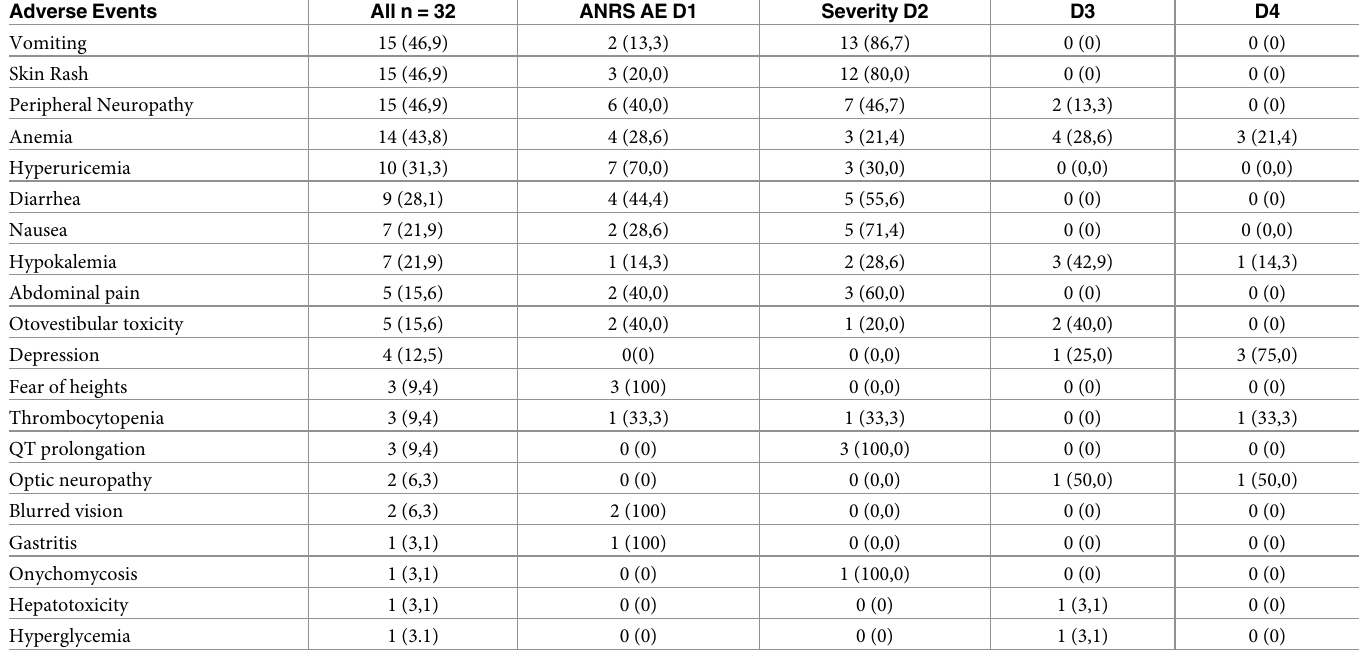
Several bedaquiline-containing treatments were applied. The most common side effects were ous AEs were reported in 9 patients. The full list of side effects is shown in the Table 3. Four patients (12.5%) had a therapeutic modification (such as discontinuation or removal of linezolid, bedaquiline, or aminoglycoside), and these drugs were replaced with another drug if necessary. The majority of deceased patients had a high dose of isoniazid in their therapeutic regimen. All treatment is given in the Table 4. Table 3. Adverse events